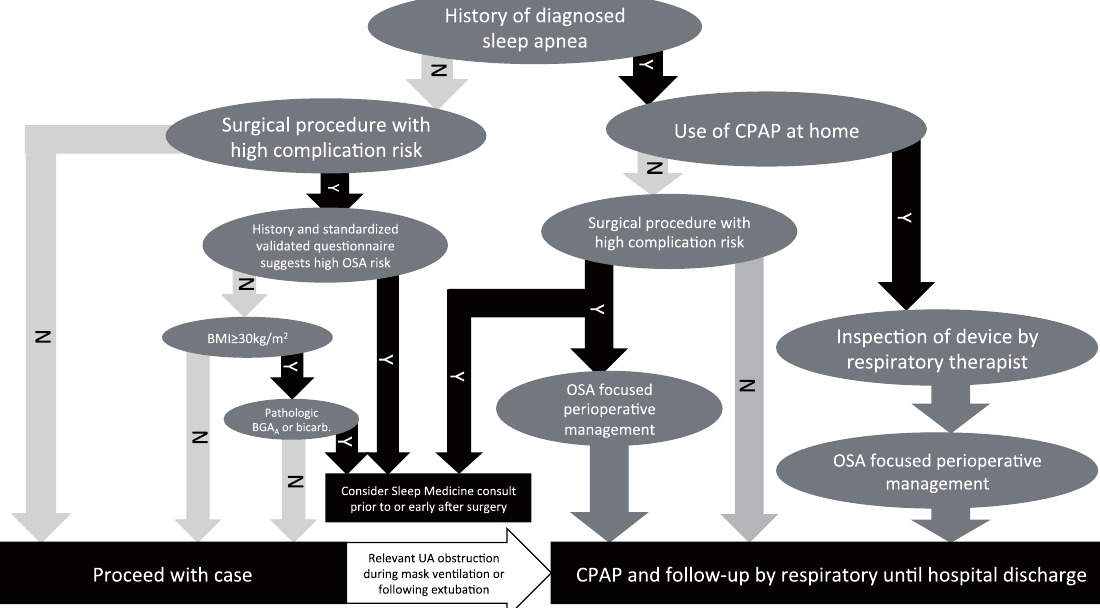
Figure 2. Algorithm for the perioperative detection and management of patients with sleep apnea (Y=yes; N=no). (modified from Zaremba S, Chamberlin NL, Eikermann M in Miller’s Anesthesia 8th Edition, by Miller RD. Eriksson LI, Fleisher LA, Wiener-Kronish JP, Cohen NH, Young WL).